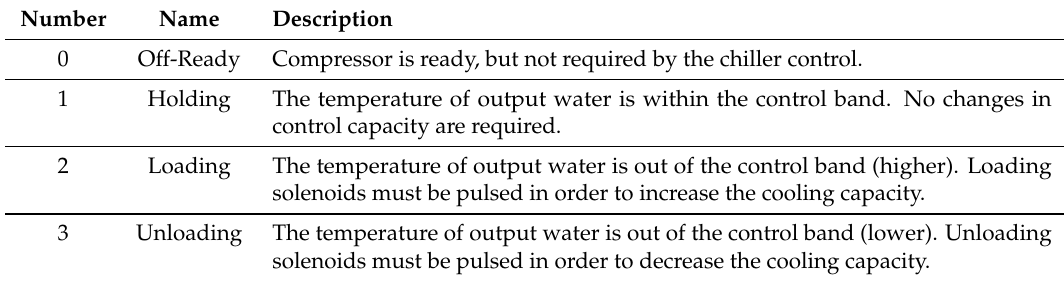
Table 1. Main control states in screw compressors.